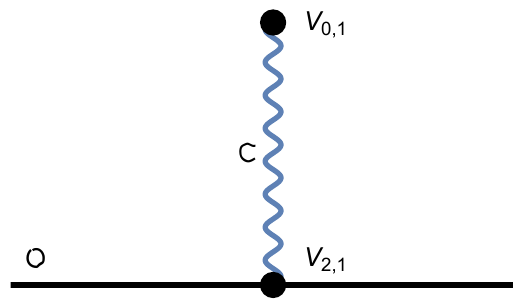
Figure 3 . A virtual closed string correction to an open string propagator. The closed string is created from the vacuum by a vertex in V 0 ; 1 . It propagates to a three-point vertex in V 2 ; 1 . This gives a correction to the open string propagator that is of the same order as a standard one-loop correction from virtual open string